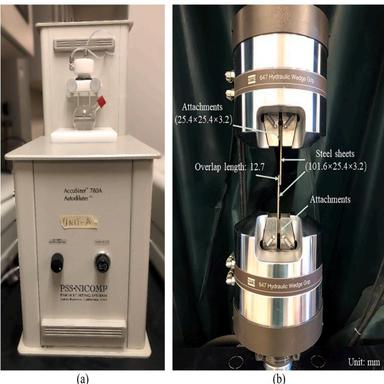
Test set-up: (a) Particle size analysis; (b) SLS test.